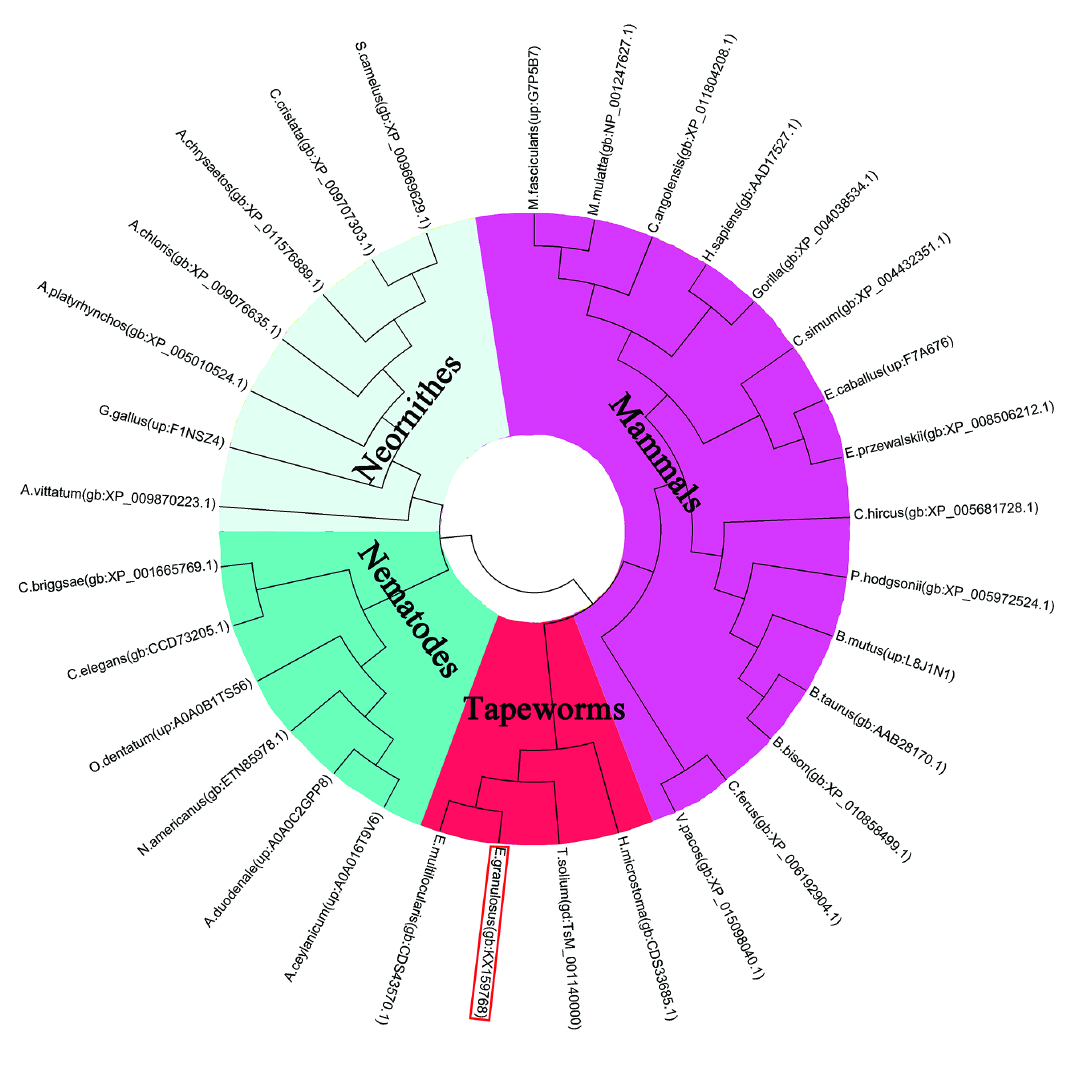
Figure 2. Phylogenetic analysis of leucine aminopeptidase protein from Echinococcus granulosus (Eg-LAP) with homologous leucine aminopeptidases. The phylogenetic tree was constructed based on the neighbor-joining method using MEGA v. 5.05. E. granulosus , Echinococcus granulosus ; E. multilocularis , Echinococcus multilocularis ; T. solium , Taenia solium ; H. microstoma , Hymenolepis microstomia ; C. elegance , Caenorhabditis elegance ; N. americanus , Necator americanus ; A. ceylanicum , Ancylostoma ceylonicum ; A. duodenale , Ancylostoma duodenale ; C. briggsae , Caenorhabditis briggsae ; O. dentatum , Oesophagostomum dentatum ; G. gallus , Gallus gallus ; A. chloris , Acanthisitta chloris ; S. camelus , Struthio camelus ; C. cristata , Cariama cristata ; A. platyrhynchos , Anas platyrhynchos ; A. vittatum , Apaloderma vittatum ; A. chrysaetos , Aquila chrysaetos ; B. taurus , Bos Taurus ; B. bison , Bison bison ; B. mutus , Bos mutus ; C. hircus , Capra hircus ; P. hodgsonii , Pantholops hodgsonii ; V. pacos , Vicugna pacos ; C. ferus , Camelus ferus ; C. simum , Ceratotherium simum ; E. caballus , Equus caballus ; E. przewalskii, Equus przewalskii ; H. sapiens , Homo sapiens ; M. mulatta , Macaca mulatta ; M. fascicularis , Macaca fascicularis ; C. angolensis , Colobus angolensis . gb, GenBank ID; gd, GeneDB ID; up, UniProt